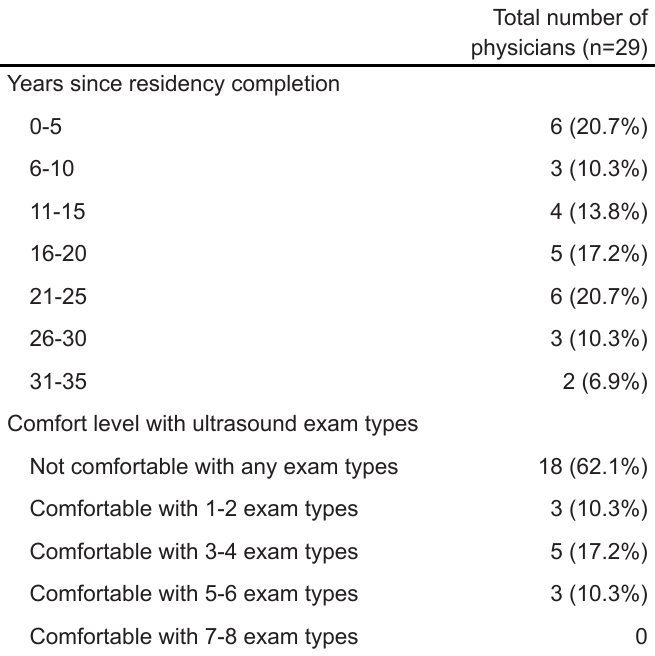
Table 2. Baseline characteristics of the physician group before the first training block.